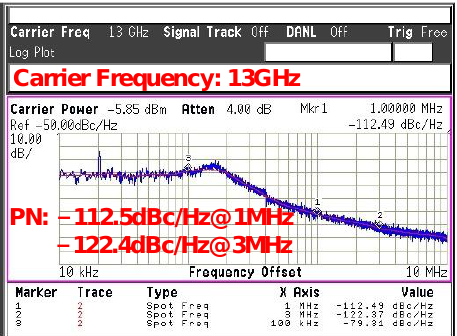
Figure 14. Measured phase noise @ 13GHz of the frequency synthesizer. The transient behavior of the frequency synthesizes shown in Figure 15 with the VCO output frequency hopping from 12.6 GHz to 12.7 GHz in one of the 32 VCO frequency sub- bands. We can see the control voltage of the VCO is set to 0.6 V during frequency-search time, and the AFC is operating to choose an optimum sub-band with sustaining about 6 µ s. Then, the control voltage begins to fluctuate and settles to a steady-state finally. The ALBC is tuned on to automatically control the loop bandwidth from about 300 KHz when the PLL is far away from the locked state, to about 150 KHz when approaching the locked state. Figure 15 depicts that the lock-time can be shortened by about 30% from 36 µ s to 24 µ s, with the ALBC off and on respectively.